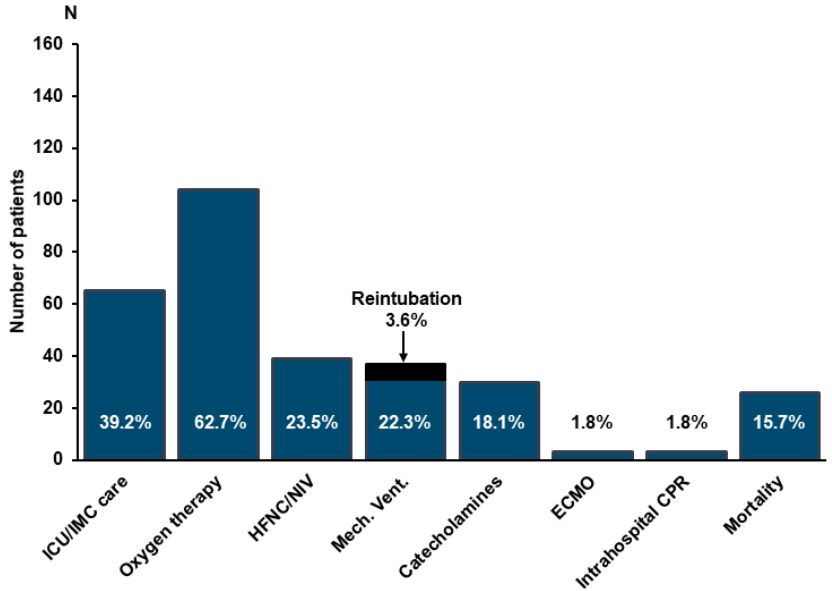
Figure 1. Clinical outcome in the overall cohort. Clinical endpoints are depicted as number of cases and percentage in relation to the entire cohort of 166 patients. CPR = cardiopulmonary resuscitation; ECMO = extracorporal membrane oxygenation; HFNC = high flow nasal canula; ICU = intensive care unit; IMC = intermediate care; NIV = non ‐ invasive ventilation.